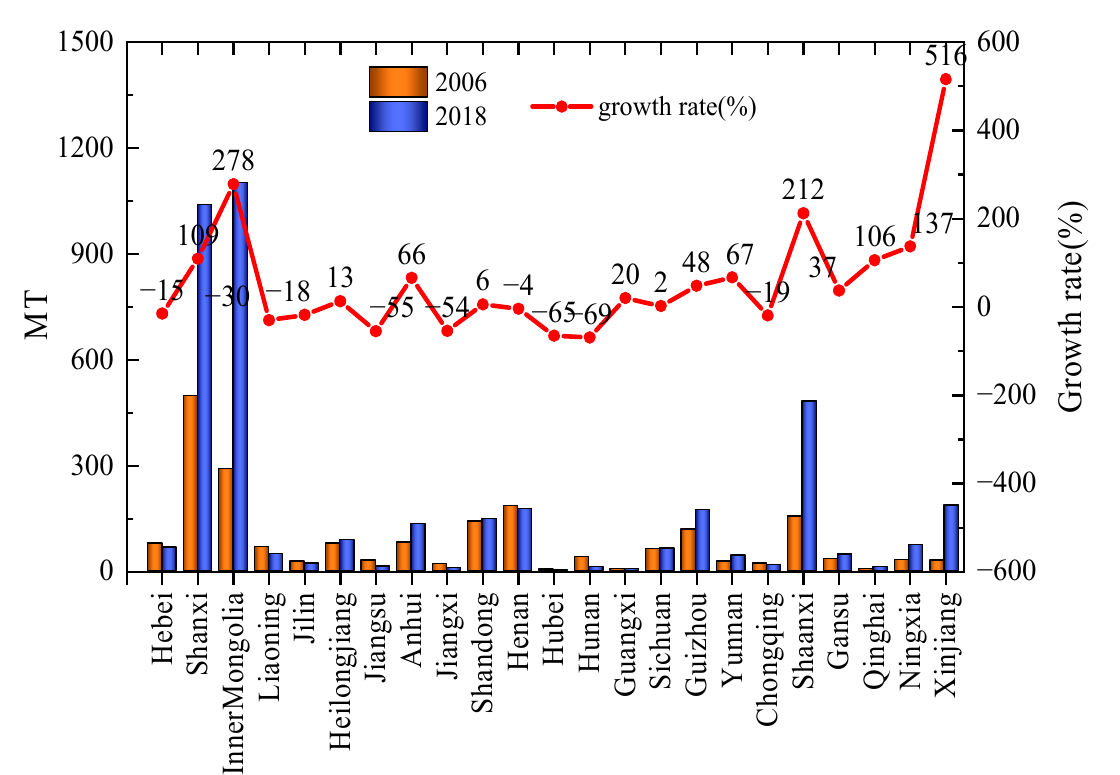
Figure 5. The changes in coal production in China’s major coal-producing provinces.